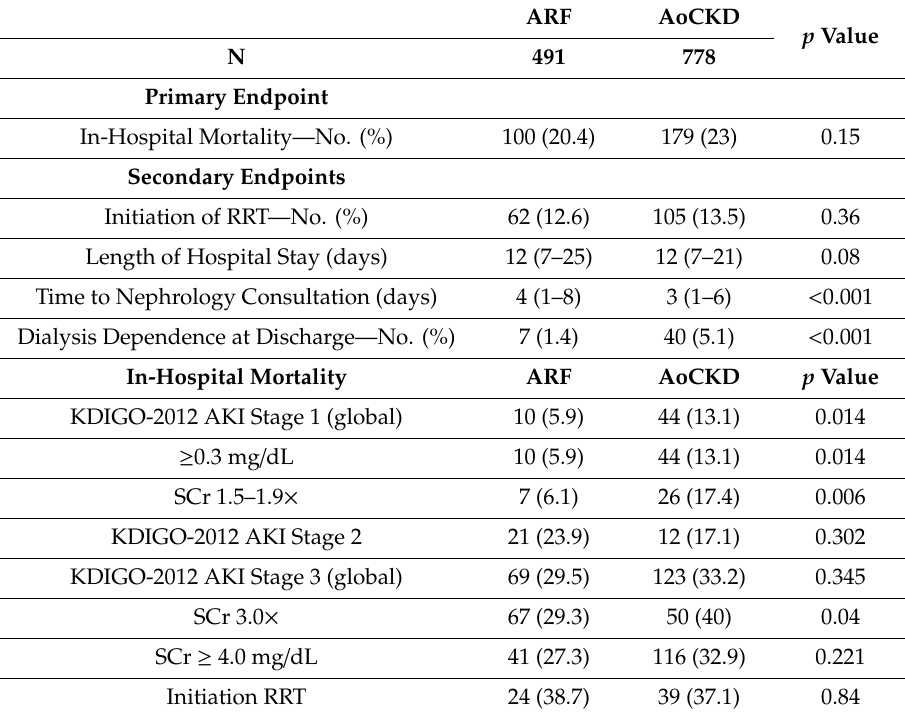
Table 3. Primary and secondary endpoints. Mortality rates of subjects that met each KDIGO stage / criterion within P-AKI / AoCKD groups. ARF AoCKD p Value N 491